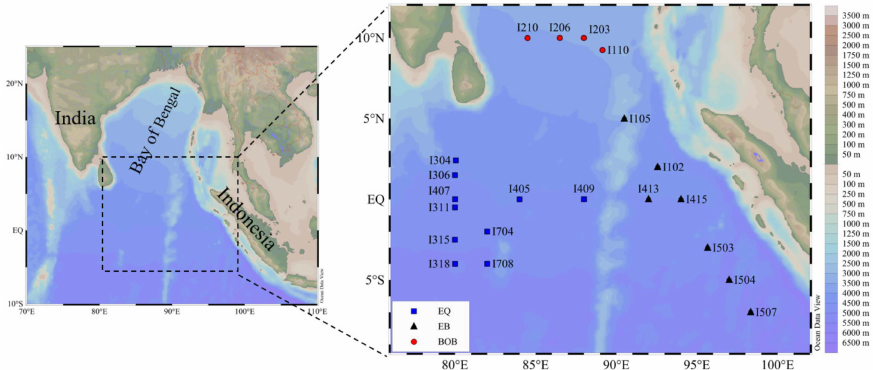
Figure 1. Maps of the study area and the distribution of sampling stations. Bay of Bengal (BOB), the Equator (EQ), and the eastern border of the Indian Ocean near Sumatra